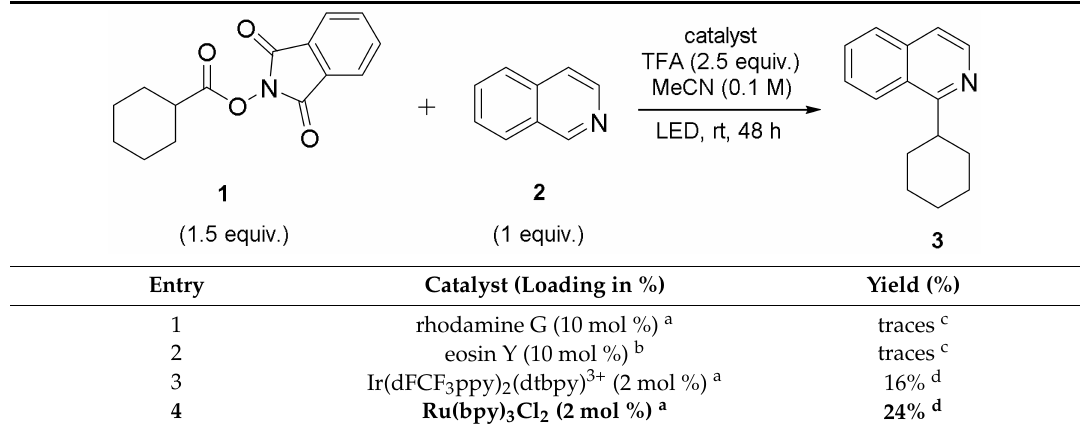
Table 1. Catalyst screening. a A 100 W blue LED module was used for irradiation; b A 100 W green LED module was used for irradiation; c Detected via HPLC; d Isolated